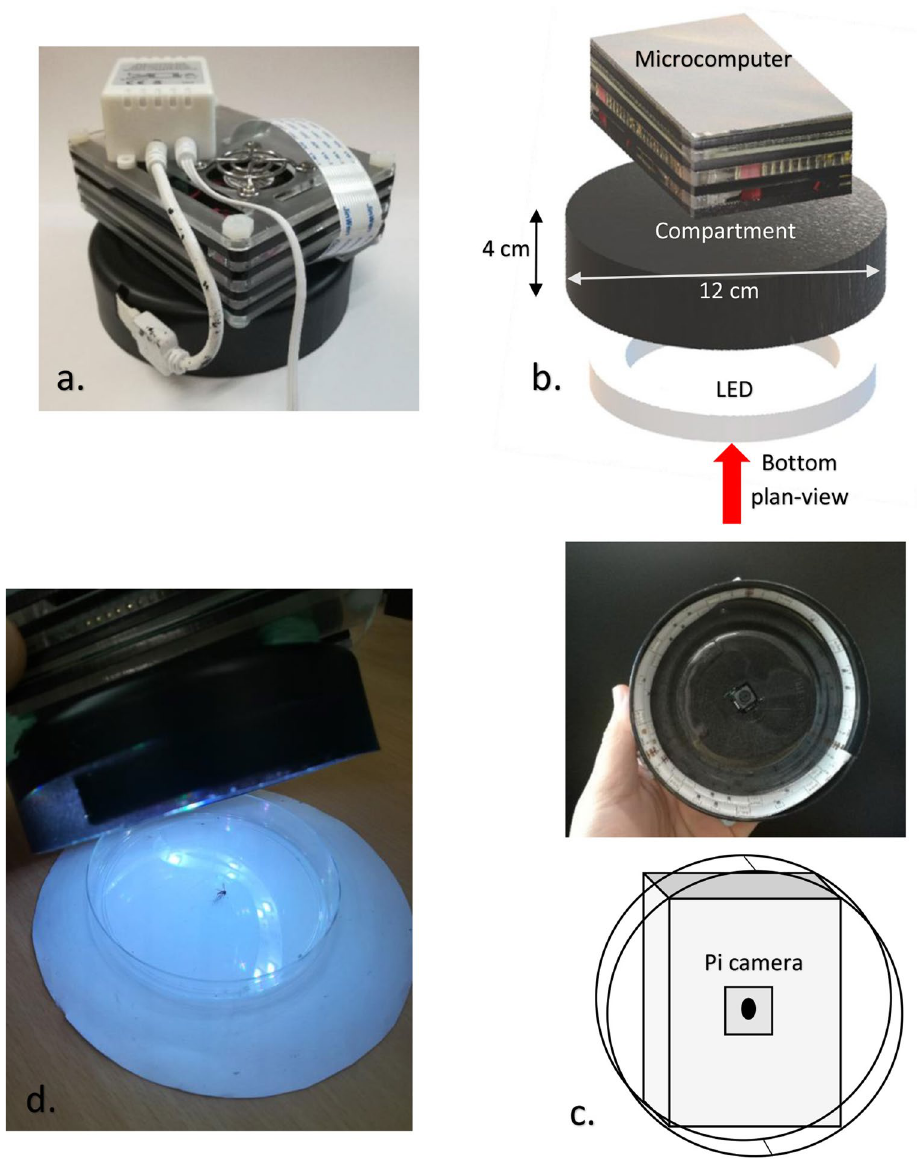
Figure 1. Aedes Detector: ( a ) actual device demo; ( b ) 3-dimensional isometric projection of the device with the components and dimensions; ( c ) bottom plan-view and the position of the Pi camera; ( d ) operation of the device with a sample at the center of the Petri